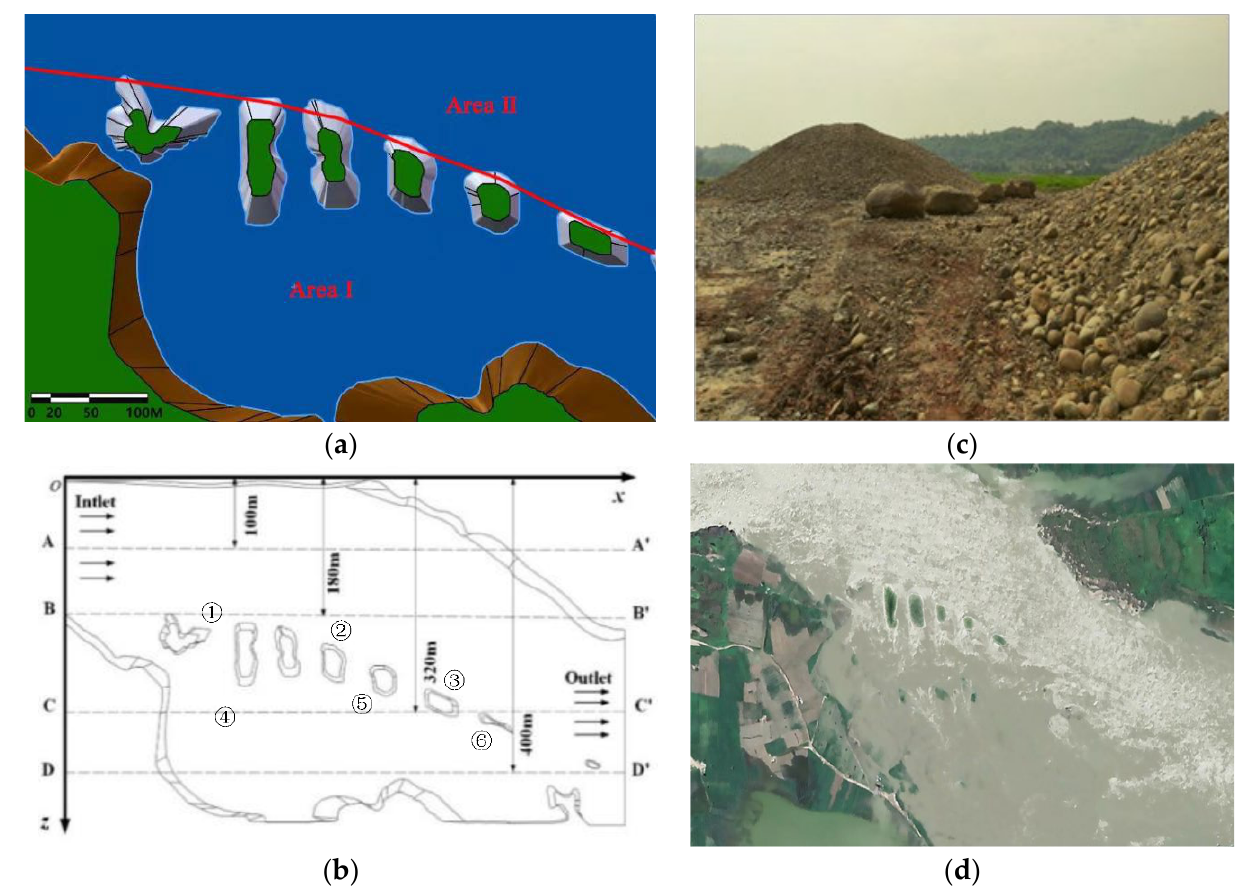
Figure 2. Location of the 6 gravel bars constructed. Water flows in the west to east. ( a ) To study the impact of constructed gravel bars on water flow and describe the geomorphic heterogeneity alteration in different areas, we defined the southern area of the gravel bars as Area I and the northern portion as Area II. ( b ) A geometric model of the project area. AA’, BB’, CC’, and DD’ are the four cross-section lines in the longitudinal direction. AA’ and BB’ were set in Area II, while CC’ and DD’ were set in Area I. “ 1 (cid:13) ” indicates sampling point II-1; “ 2 (cid:13) ” indicates sampling point II-2; “ 3 (cid:13) ” indicates sampling point II-3; “ 4 (cid:13) ” indicates sampling point I-1; “ 5 (cid:13) ” indicates sampling point I-2; and “ 6 (cid:13) ” indicates sampling point I-3. ( c ) Gravel bars under construction. ( d ) Aerial photograph of gravel bars at high water level period (water depth 4.0 m).